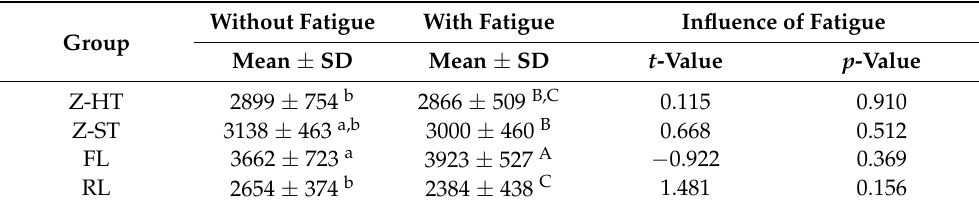
Table 3. Descriptive statistics of failure load in [N]. Different superscript letters per column without (small letters) or with fatigue exposure (capital letters) indicate statistically significant differences ( p < 0.05) between materials. Results of t -tests ( t -value, p -value) show the effect of fatigue for each type of material (per row).